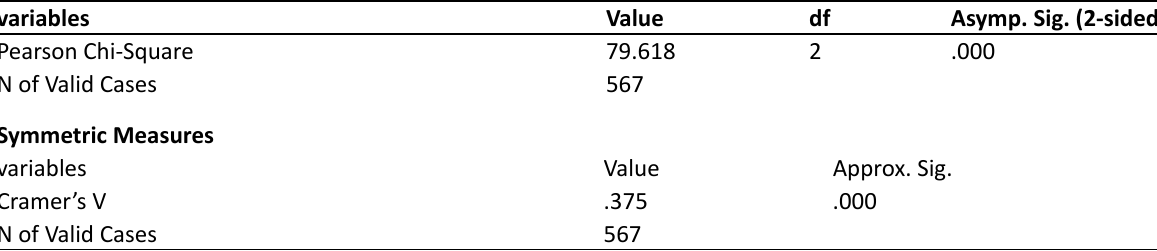
Table3. Results of the Chi-Square test and of Cramer’s V coefficient in relation to the country of origin and adherence to